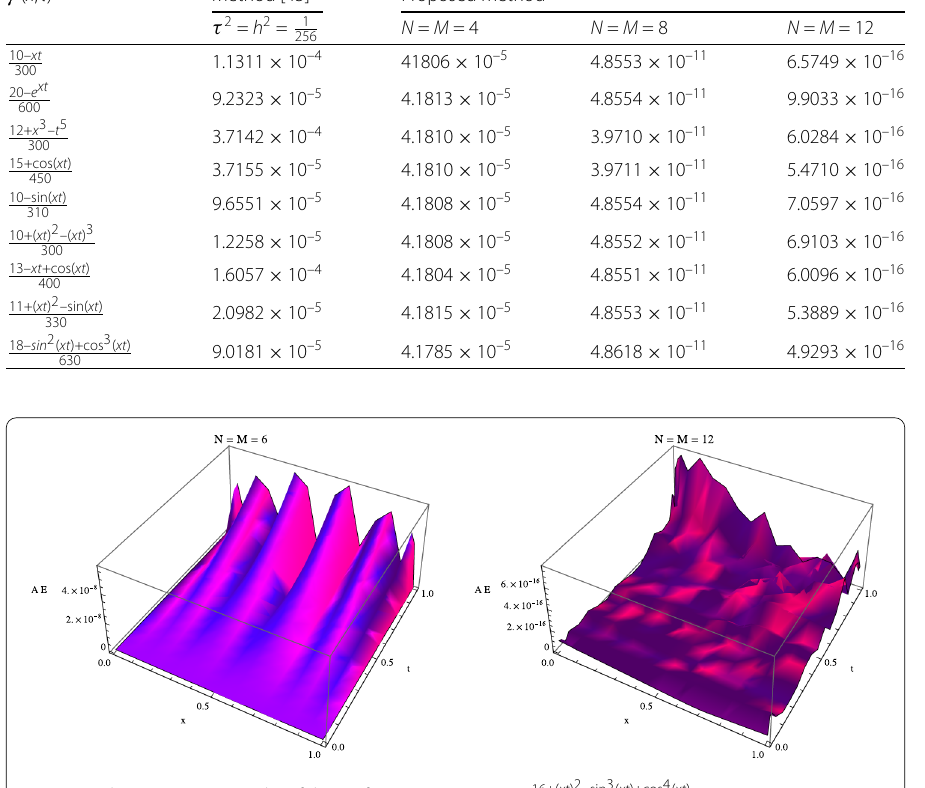
Figure 1 The space-time graphs of the AE functions at γ ( x , t ) = 16+( xt )2–sin3( xt )+cos4( xt )